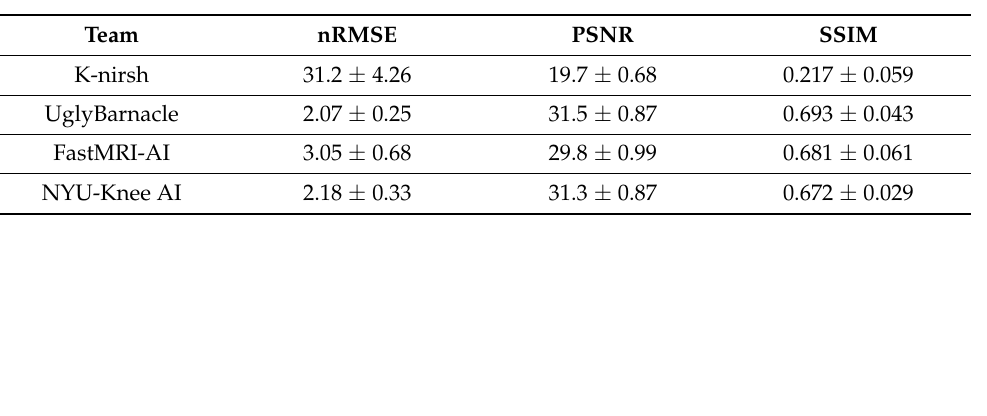
Table 3. Standard reconstruction metrics for intermediate pipeline outputs from all top submissions across the released test set (n = 50). Results are presented mean ± 1 s.d. The top pipeline by each of these metrics was UglyBarnacle, shown in